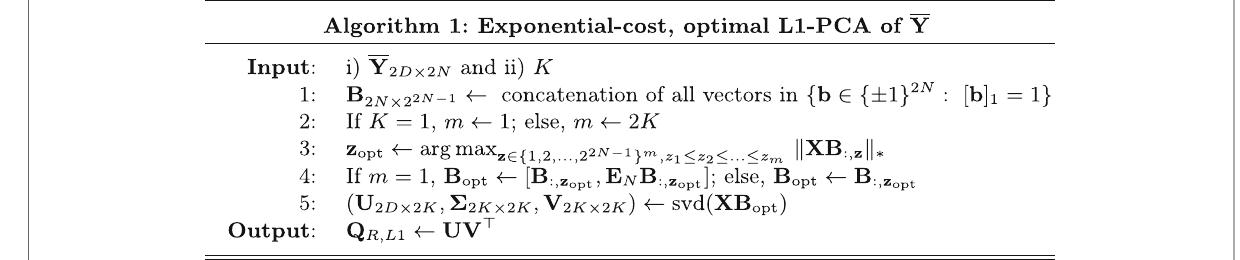
Fig. 2 Algorithm for optimal computation of the 2 K L1-PCs of rank-2 D data matrix Y 2 D × 2 N with exponential (w.r.t. N ) asymptotic complexity (cid:9) (cid:12) O 2 2 Nm ( m = 1, for K = 1; m = 2 K , for K >